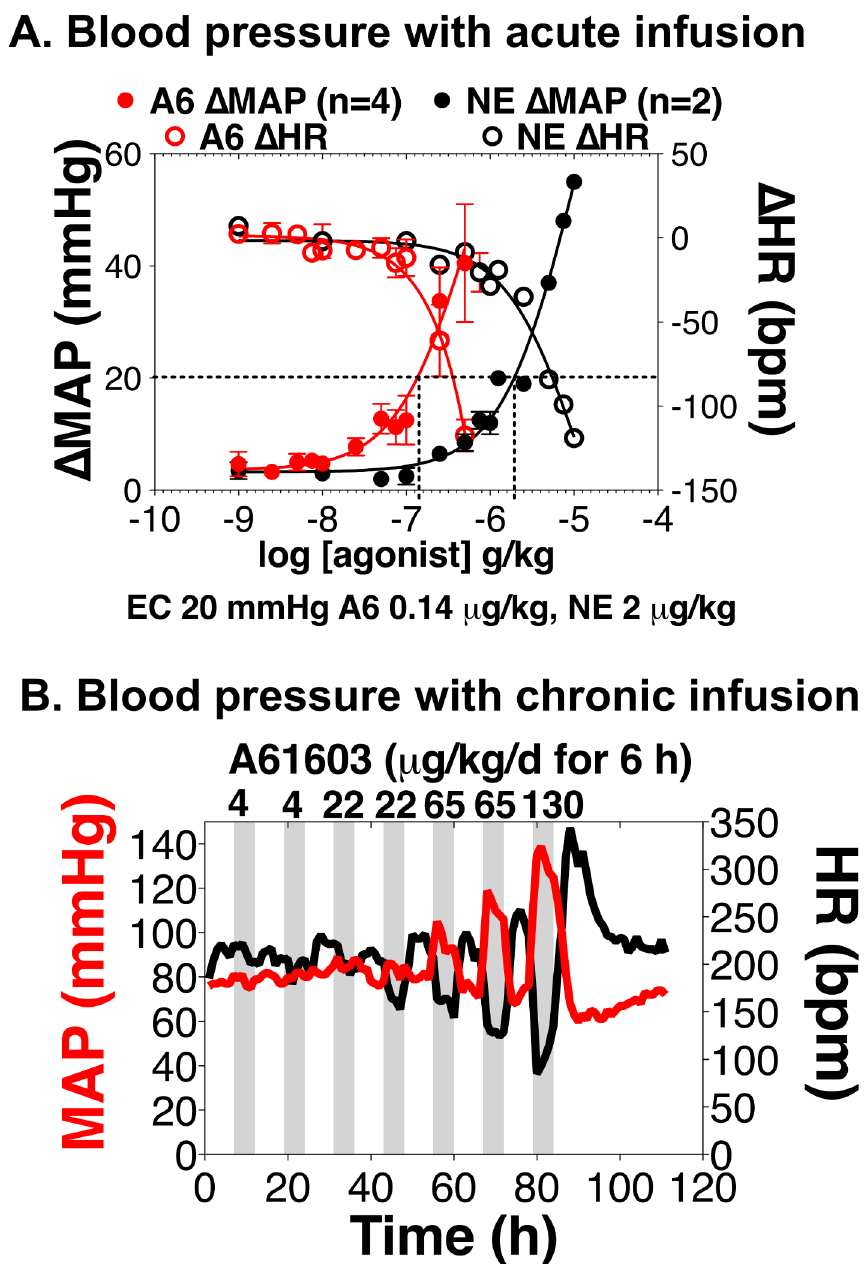
Fig 4. Pressor effects of A61603 in awake rabbits. BP and HR were measured in awake, restrained rabbits through a catheter in the abdominal aorta and an implanted telemetry unit. A. A61603 (A6) or norepinephrine (NE) was infused acutely through an ear vein catheter in restrained rabbits. Dosing that caused a 20 mmHg increase in mean arterial pressure (MAP) is indicated. B. A61603 was infused IV in an unrestrained rabbit through a subcutaneous iPRECIO unit, programmed to deliver the dose indicated at the top of the graph for 6 h (shaded areas), with 6 h between dosing. MAP was not changed by A61603 infused at 4 or 22 μ g/kg/d.